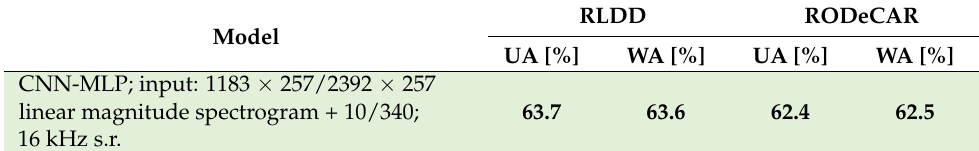
Table 11. Final CNN-MLP-based DSD cross-validation performance–RLDD and RODeCAR. RLDD RODeCAR Model UA [%] WA [%] UA [%] WA